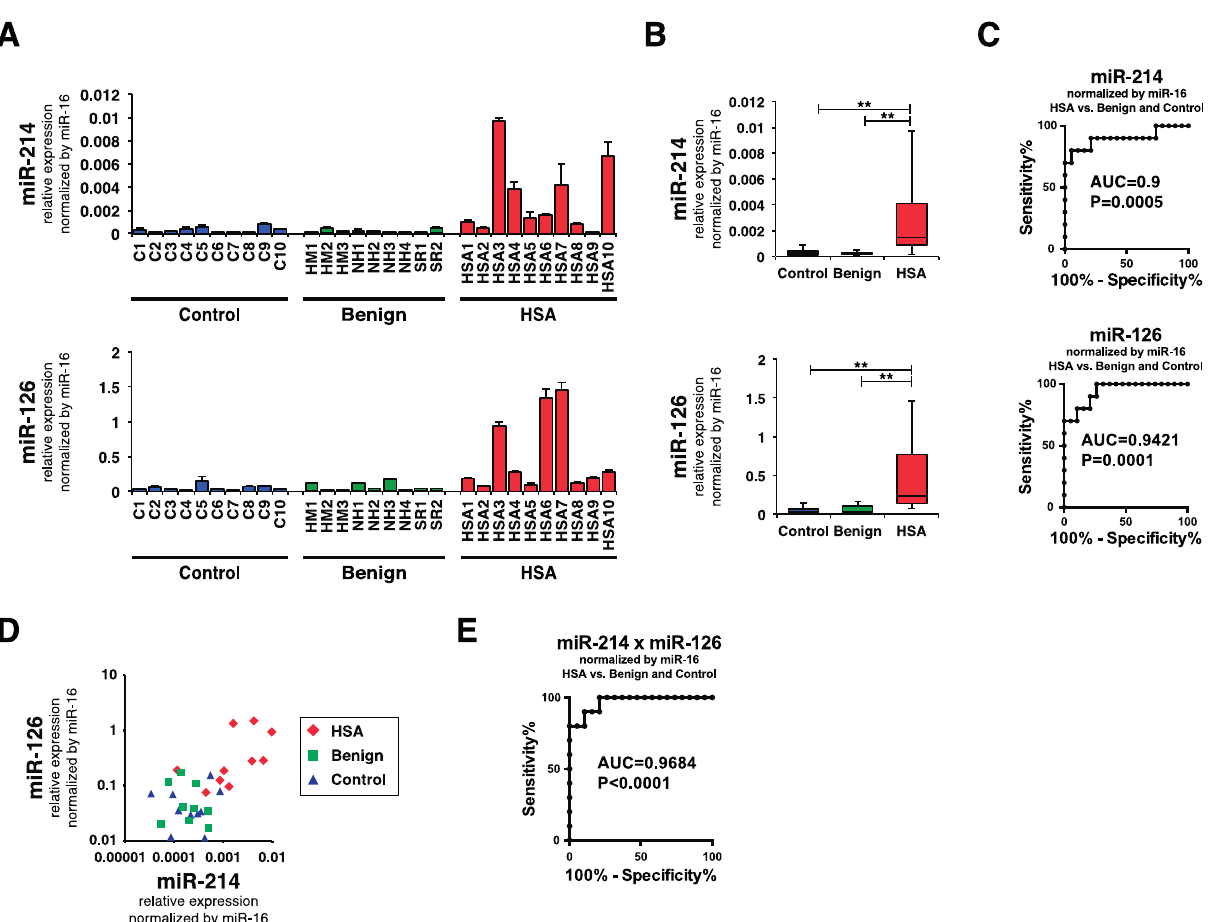
Figure 3. miR-214 and miR-126 was significantly increased in the plasma of HSA group. ( A ) Levels of miR-214 and miR-126 in the plasma of HSA, benign, and control groups. The levels of both miR-214 and miR-126 were significantly increased in the plasma from the HSA group compared with those for the benign and control groups; ( B ) Boxplots of the miR-214 and miR-126 levels in the plasma of HSA, benign, and control groups. The HSA group showed significantly increased levels of miR-214 and miR-126 (Steel-Dwass test; ** p < 0.01 for each comparison); ( C ) ROC curve analysis for the single use of miR-214 and miR-126. The AUC values of miR-214 and miR-126 were 0.9 and 0.9421, indicating the sensitivities and specificities were significantly high; ( D ) miR-214 and miR-126 showed similar profile patterns in the HSA group, which showed increased levels of both miR-214 and miR-126; ( E ) ROC curve analysis for the combination of miR-214 and miR-126. The AUC value was 0.9684, suggesting that the combination of miR-214 and miR-126 showed better accuracy than the single use of each